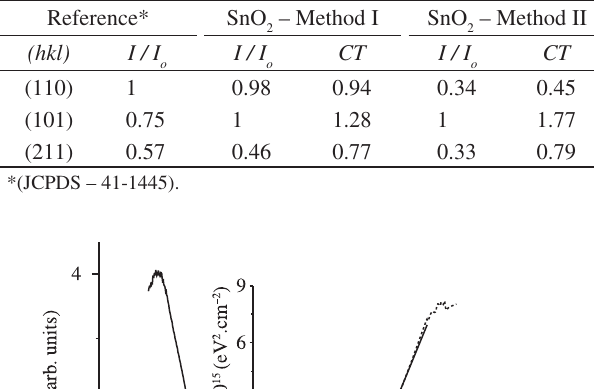
thin film. Inset – 2